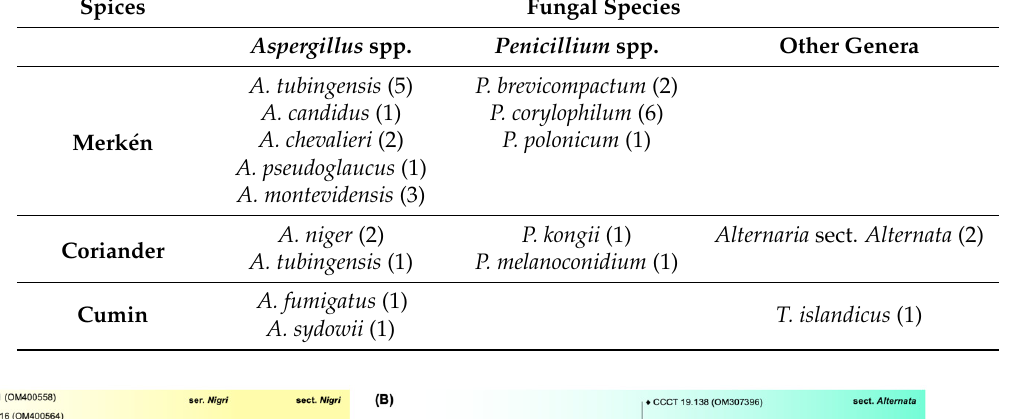
Table 1. Mycobiota isolated from Merk é n pepper samples and coriander and cumin seeds after 7 days of incubation on DRBC, DG18, and MEA at 25 ◦ C. The number of isolates of each species is indicated in parenthesis. Detailed phylogenetic analyses can be found in Figure 2.